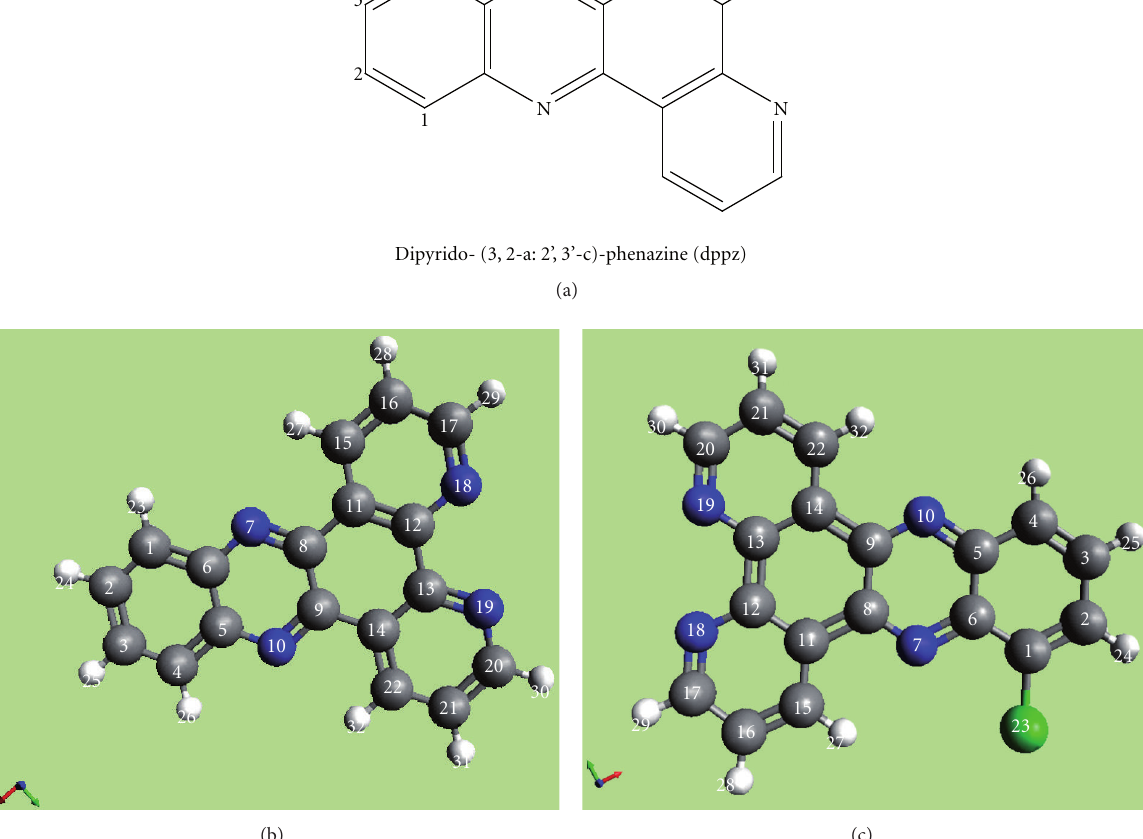
F 1: (a) Structure of dppz showing the investigated positions of chlorine substituents. (b) Optimized structure of dppz visualized in Avogadro. (c) Optimized structure of 1-chlorodppz (1-cldppz) visualized in